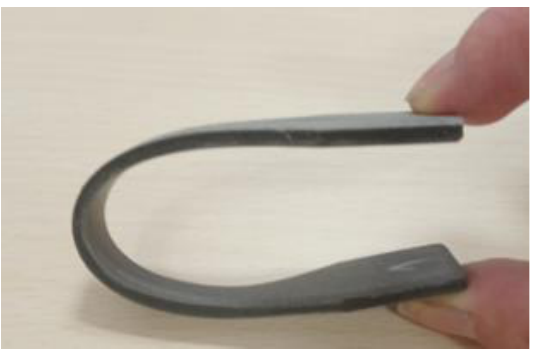
Figure 8. Dog-bone-shaped specimen, FDM-printed from filament S90/10, fully bended without breaking.